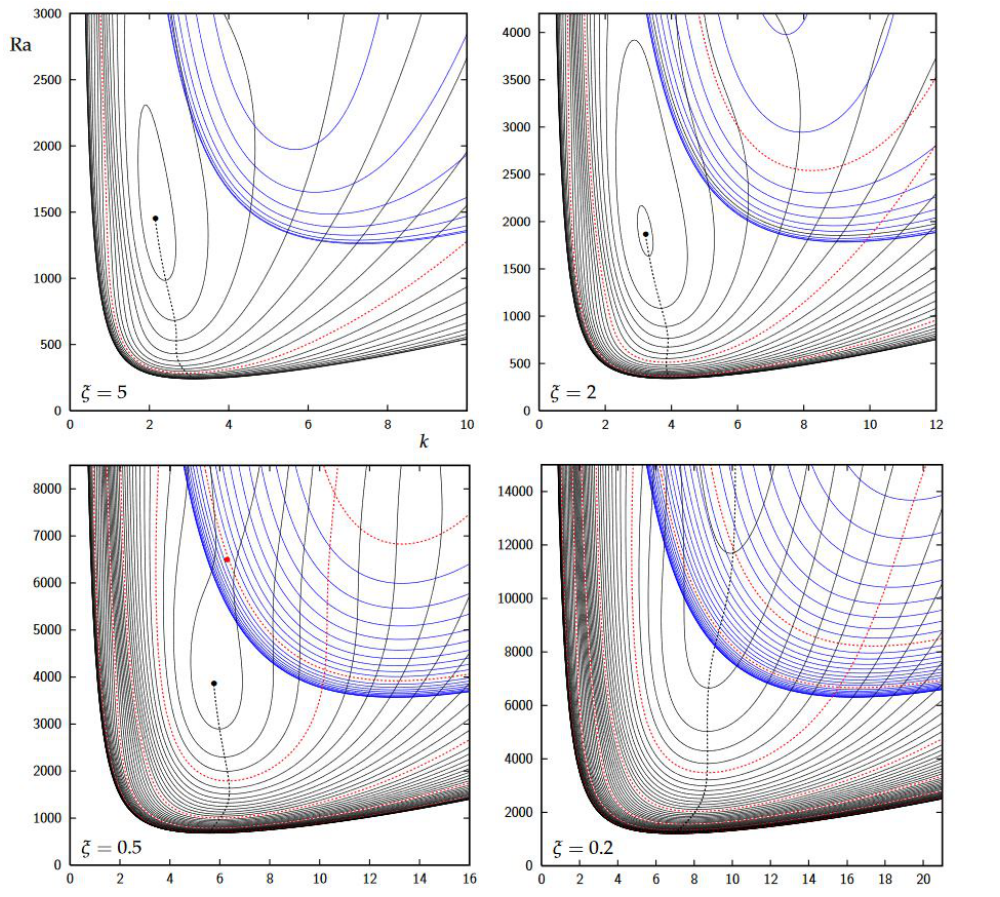
Figure 2. Showing neutral curves for transverse rolls for ξ = 5, ξ = 2, ξ = 0.5 and ξ = 0.2, and for different inclinations, α , from 0 ◦ onwards in increments of 1 ◦ . Black curves correspond to mode 1 and blue curves to mode 2. Red dotted curves correspond to α being a multiple of 10 ◦ . The black dotted line is the locus of minima while the black disk corresponds to the isola point, i.e., the largest inclination for which there is marginal stability. The red disk corresponds to a saddle